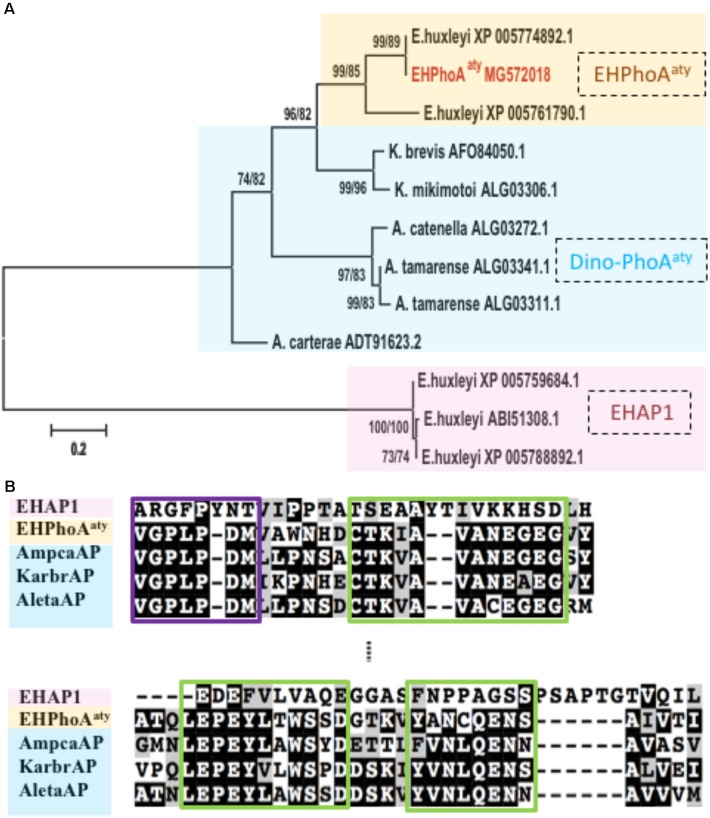
Phylogenetic analysis and conserved regions identified from alignment of amino acid sequences of EH-PhoAaty, EHAP1 and dinoflagellate APs. (A) Tree topology is shown as a Neighbor Joining tree with 1000 bootstraps and similar topology was obtained using the Maximum-Likelihood. Support value of nodes on each branch are shown as ML/NJ. Color backgrounds indicated the different types of APs. Yellow represents atypical EH-PhoAaty type from Emiliania huxleyi, blue represents the PhoAaty type from dinoflagellates (Dino-PhoAaty), and pink represents the EHAP1 type from E. huxleyi. (B) Pairwise comparison of deduced amino acid sequences of EHAP1 (XP 005759684.1), EHPhoAaty (MG572018), AP of dinoflagellate Amphidinium carterae (AmpcaAP, ADT91623.2), Karenia brevis (KarbrAP, AFO84050.1), Alexandrium tamarense (AletaAP, ALG03341.1). Green boxes represent identified conserved domains in PhoAaty (Lin X. et al., 2015).